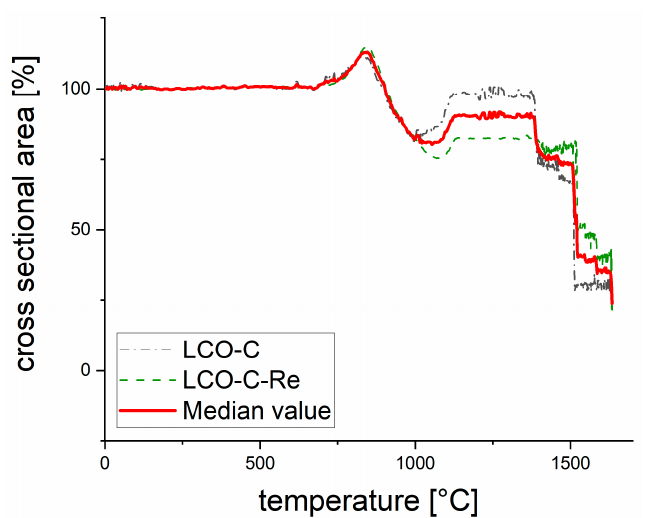
Figure 6. Results of the heating microscope of LCO-C: trend of the cross-sectional area of the experiments LCO-C and LCO-C-Re during heating and the median value of the both graphics.